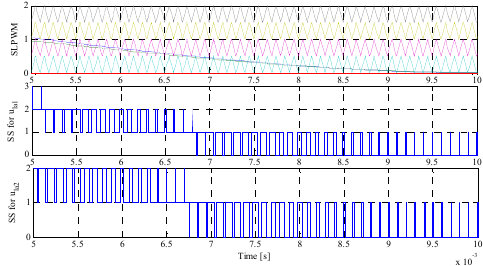
Figure 9. A typical shifted ‐ level PWM for proposed lower modulation function with input current changes.